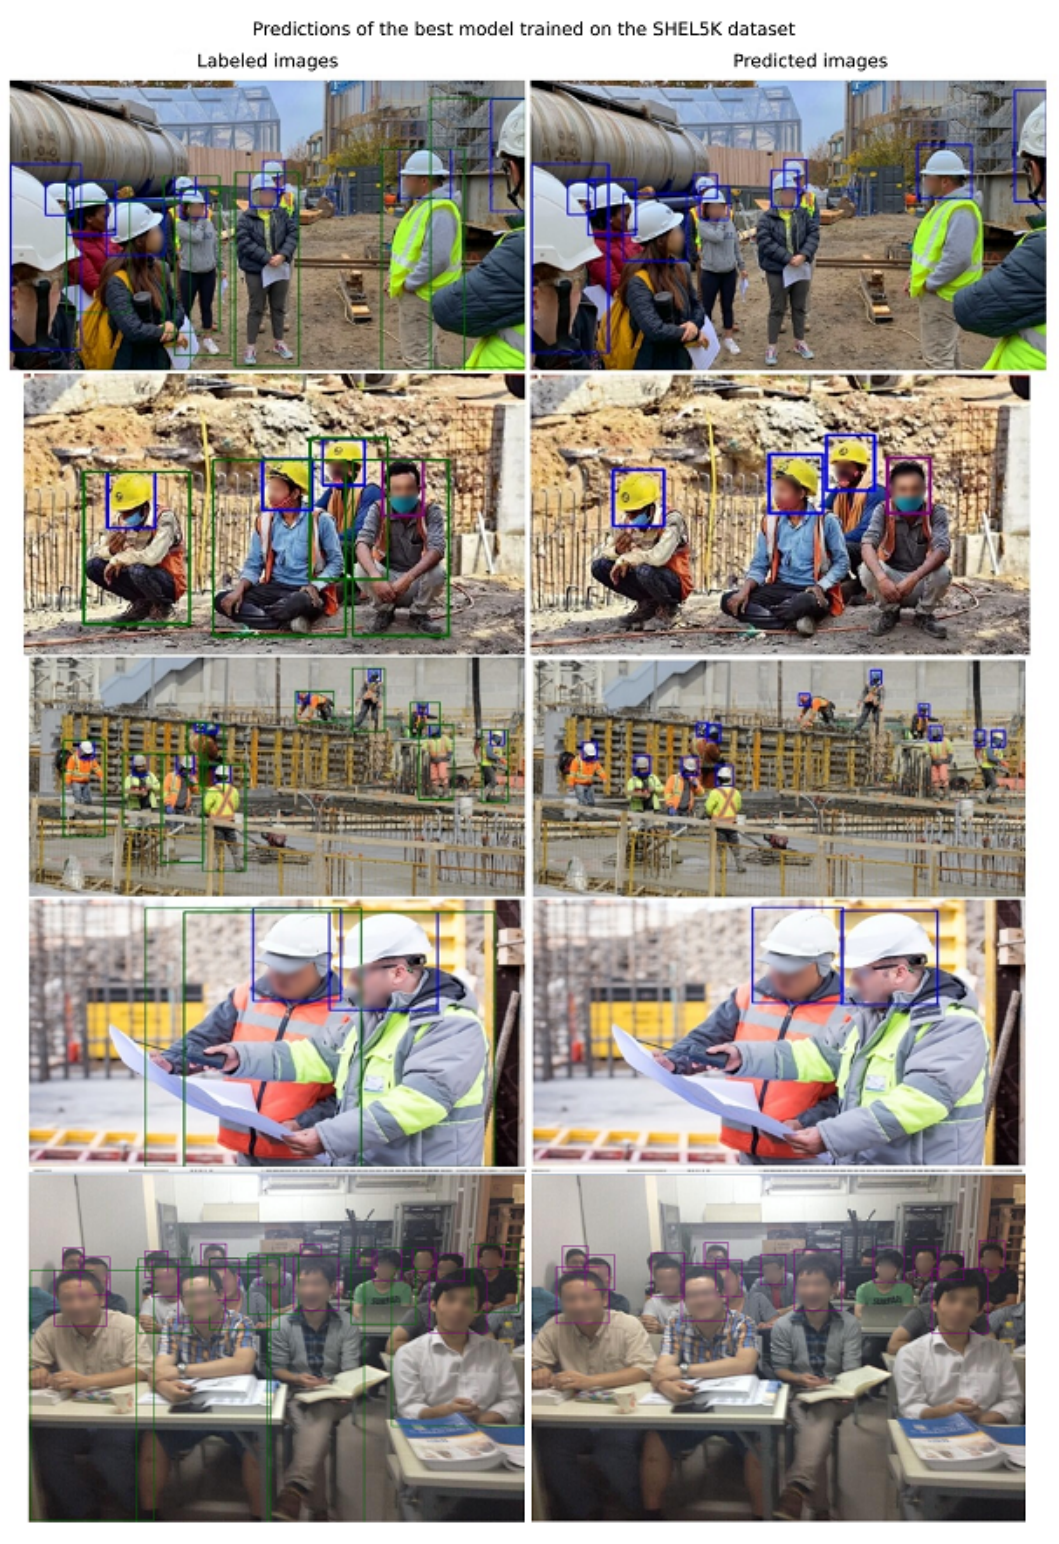
Figure A5. Predictions of the best model trained on the HHW dataset [27] and the ground truth labels of the sample